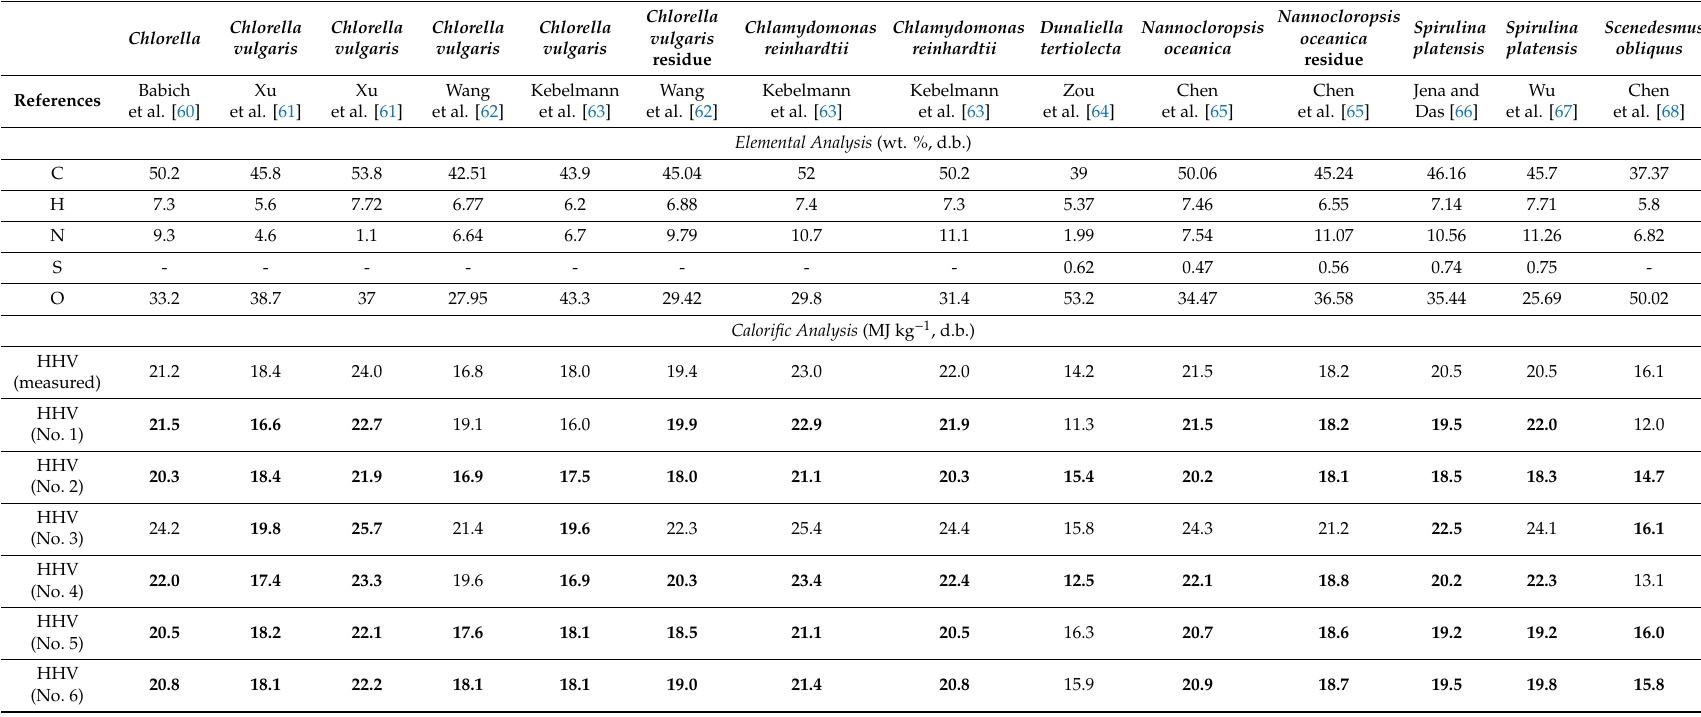
Table 3. Published results on the elemental and calorific analysis for di ff erent microalgae biomasses. For each case, the published High Heating Value (HHV) is shown together with the HHV estimated by correlations based on elemental analysis displayed in Table 1. Estimated HHVs that are within ± 10% the measured value are in